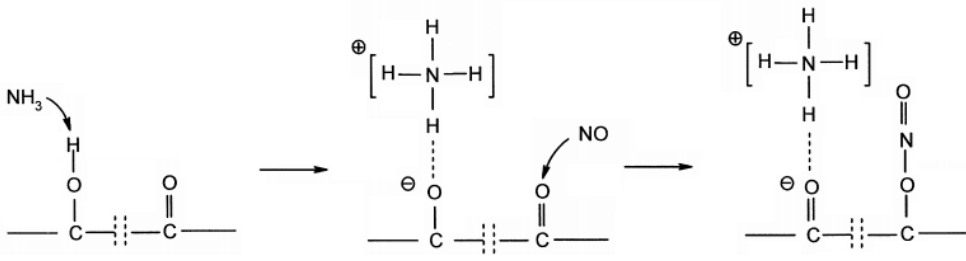
Figure 3. E ff ect of AC in NO / NH 3 / N 2 system (1000 µ L / L NO + 1000 µ L / L NH 3 ).